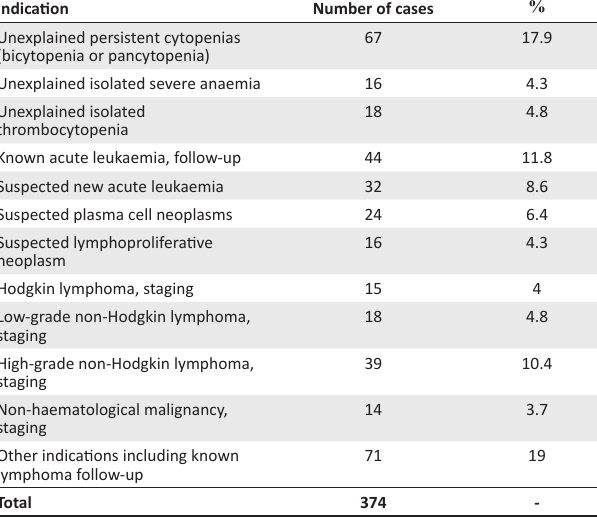
TABLE 1: Indications of bone marrow biopsies in the HIV-positive individuals. Indication